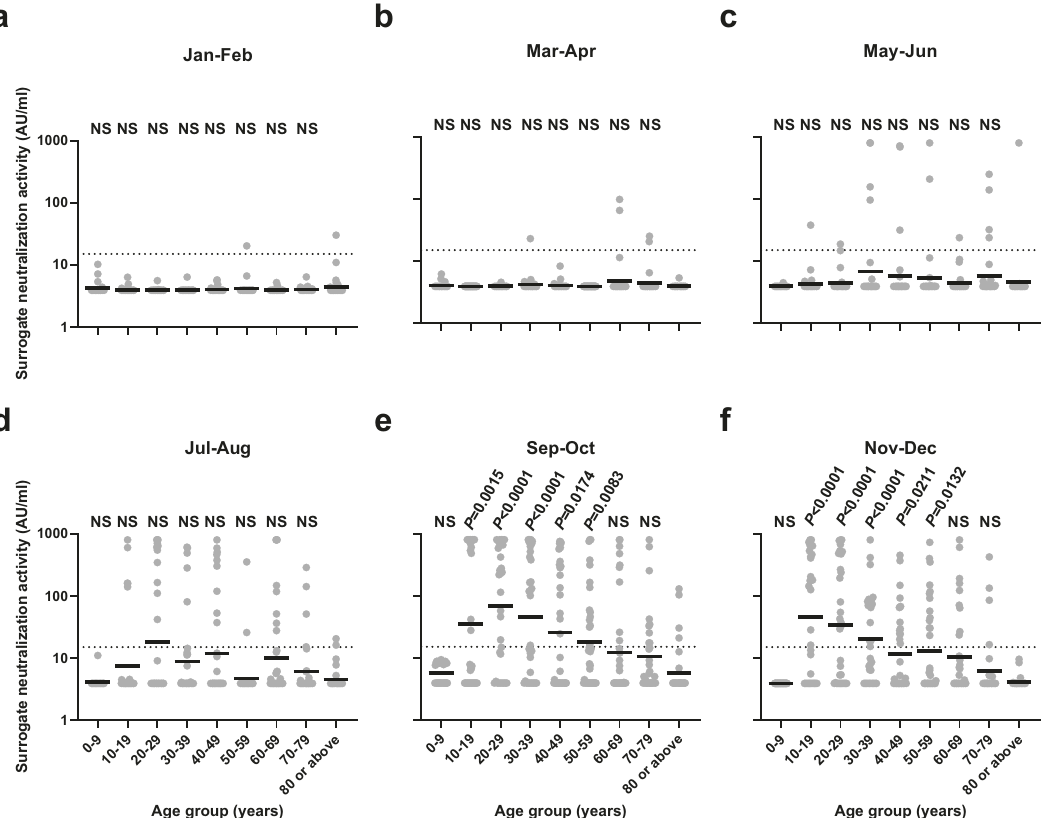
Fig. 3 Comparison of surrogate neutralization activity among different age groups. a – f Surrogate neutralization activity in different time periods. The horizontal bar indicates the geometric mean level. Dotted horizontal lines represent the manufacturer ’ s seropositivity cutoff level (15 AU/ml). The geometric mean antibody titer for each age group was compared to the ≥ 80 years age group using the one way ANOVA with Dunn ’ s multiple comparisons test. The number of serum specimens tested in each period is shown in Supplementary Table S1. Source data are provided as a Source Data fi le. NS, not signi fi